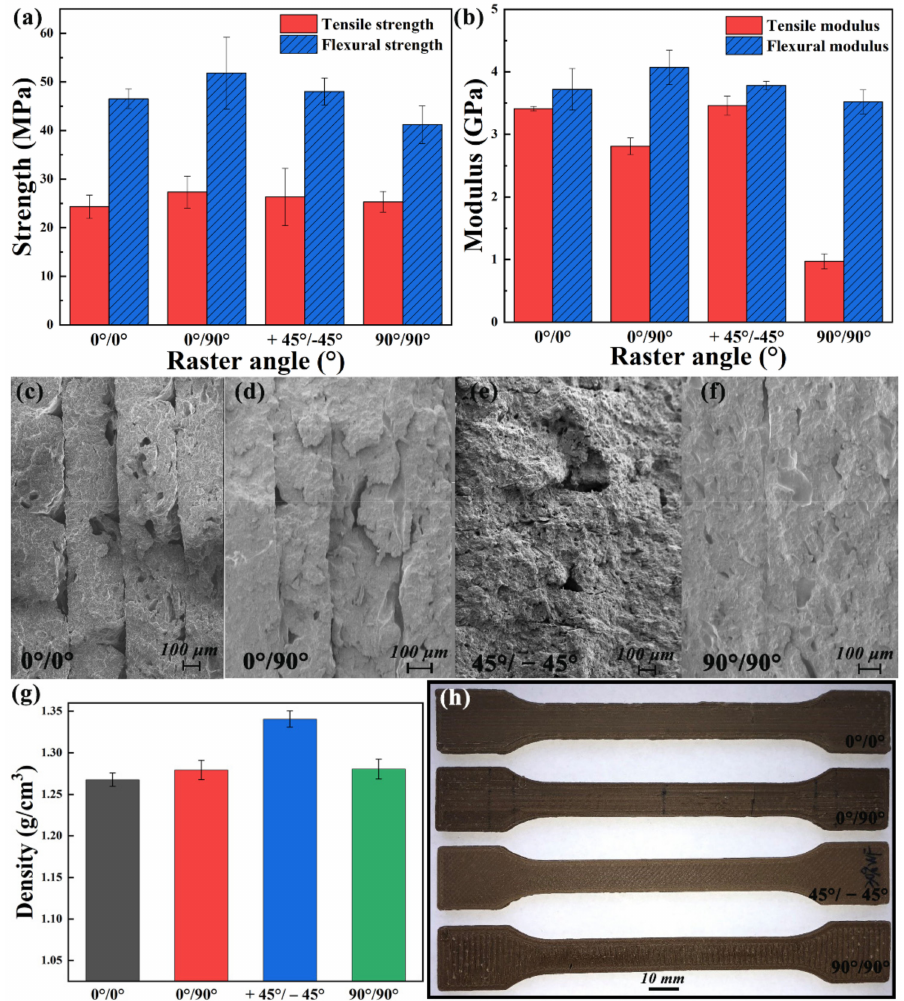
Figure 8. ( a ) Mechanical strength and ( b ) modulus, ( c – f ) SEM images of the fractured cross-section, ( g ) density and ( h ) surface quality of samples printed at various raster